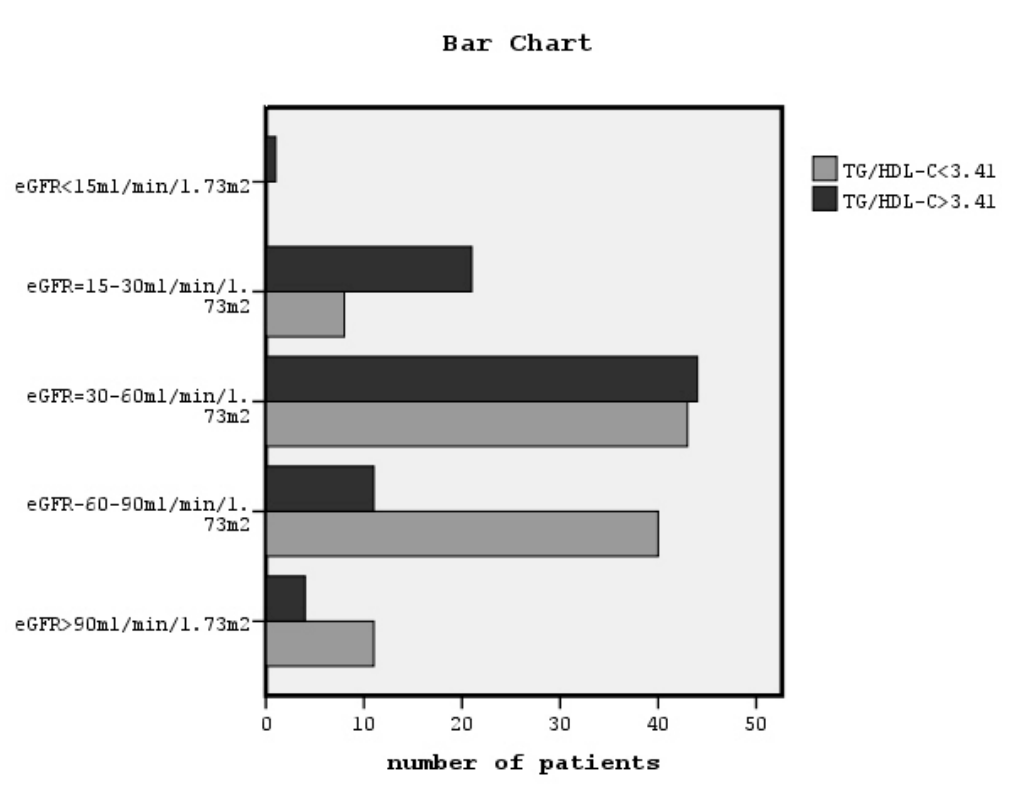
Figure 2. The association between TG/HDL-C ratio greater or lower than the cut-off point related to an eGFR of less than 60 mL/min/1.73 m 2 and classified eGFR (x 2 = 24.5, p = 0.001).